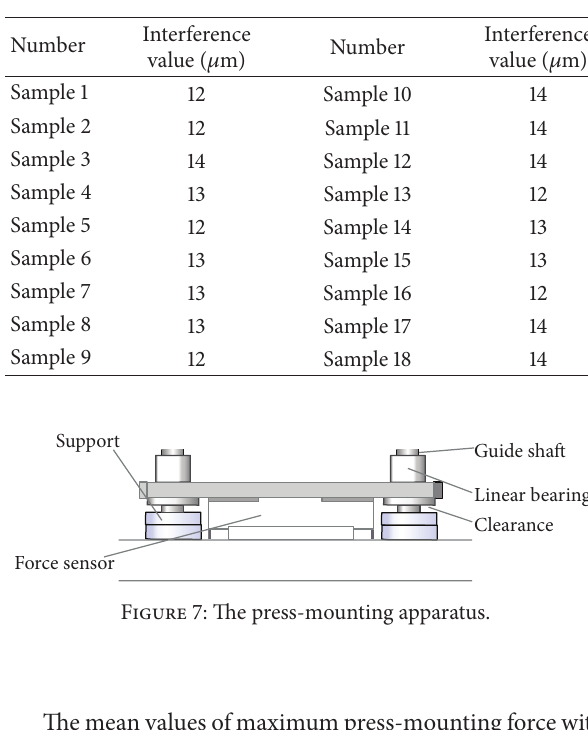
Table 5: Interference values of samples.